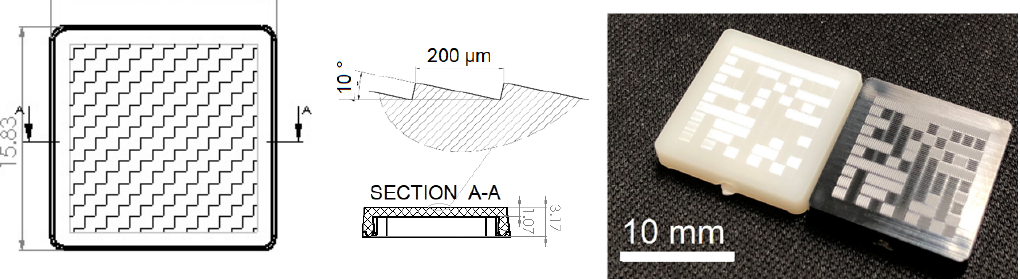
Figure 11. Design specification of the micro-optical reflector ( left ) with a highlight of its surface structures ( center ); injection molded part and tool cavity insert ( right ) [32].